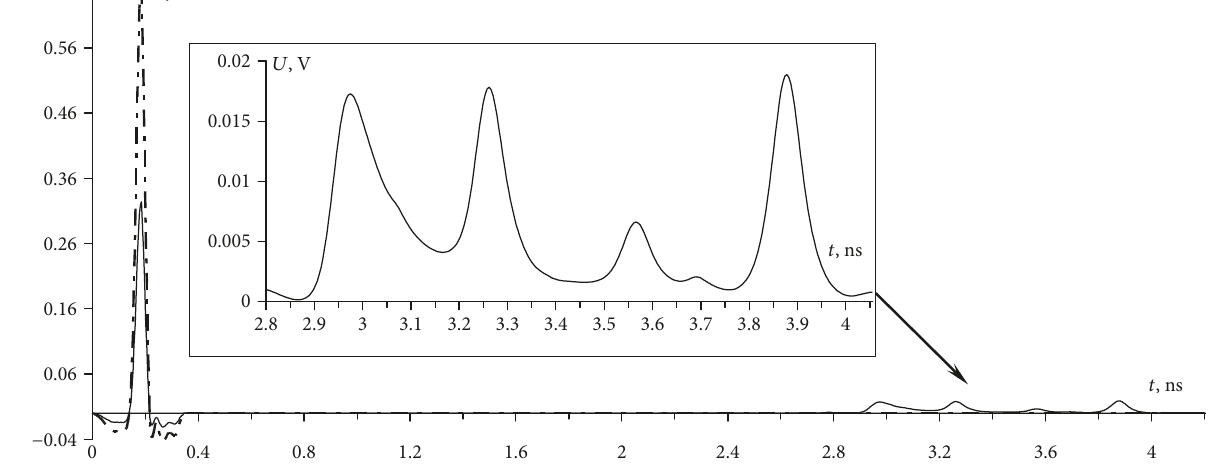
Figure 13: Waveforms of the EMF ( – · – ) and input ( — ) and output ( — ) voltages (with enlarged fragment of the voltage waveform at the output) of a four-conductor microstrip line MF with the parameters obtained as a result of fi ve-criterion GA optimization of fi ve